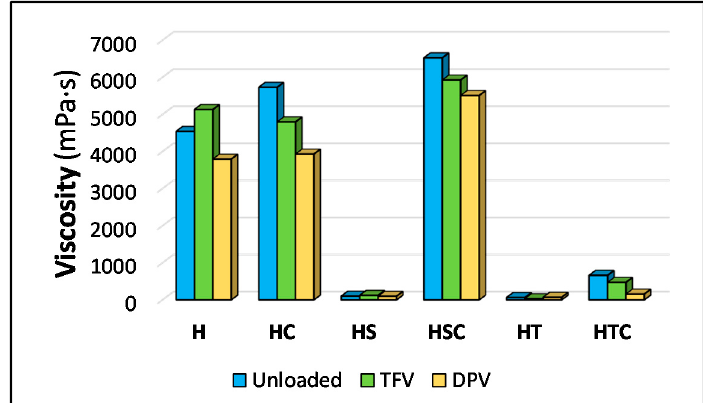
Figure 2. Viscosity of each batch of gels.